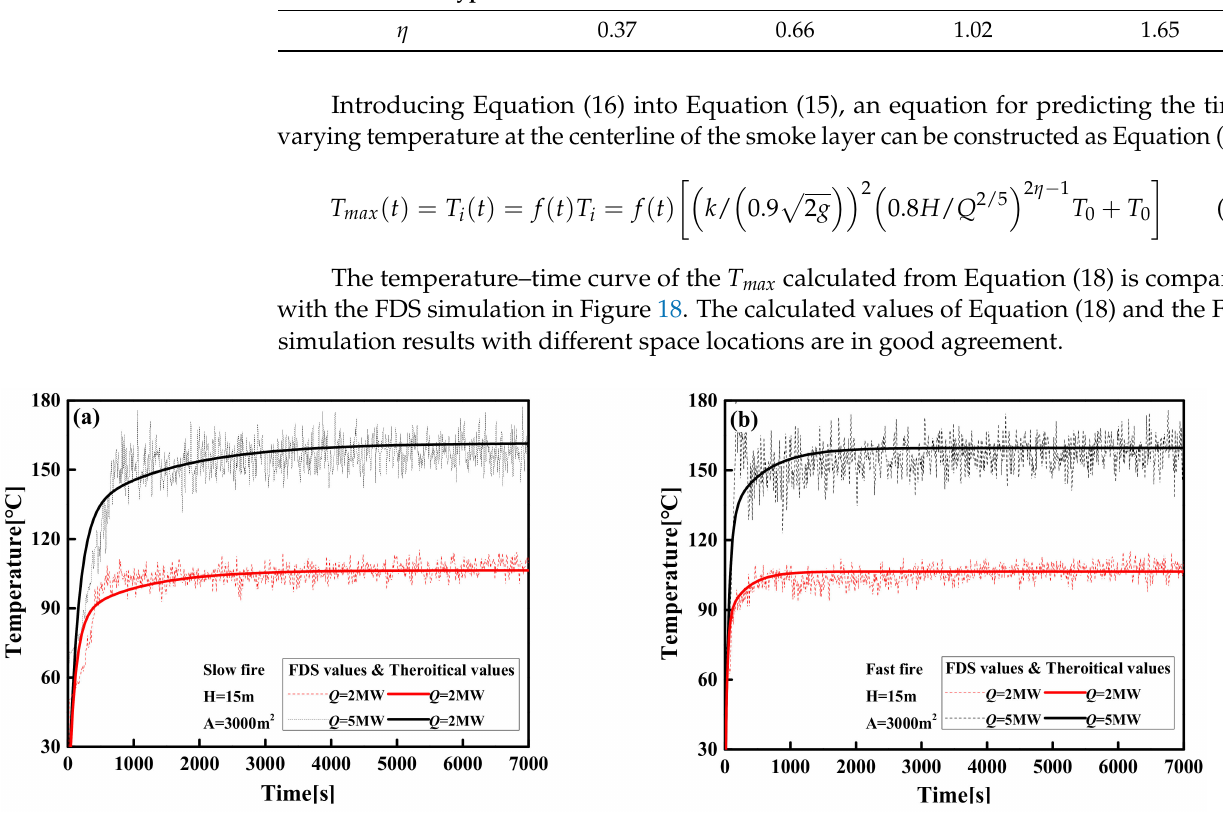
Figure 18. Comparisons of theoretical prediction and FDS simulation of the T max in large-space buildings: ( a ) slow fire; ( b ) fast